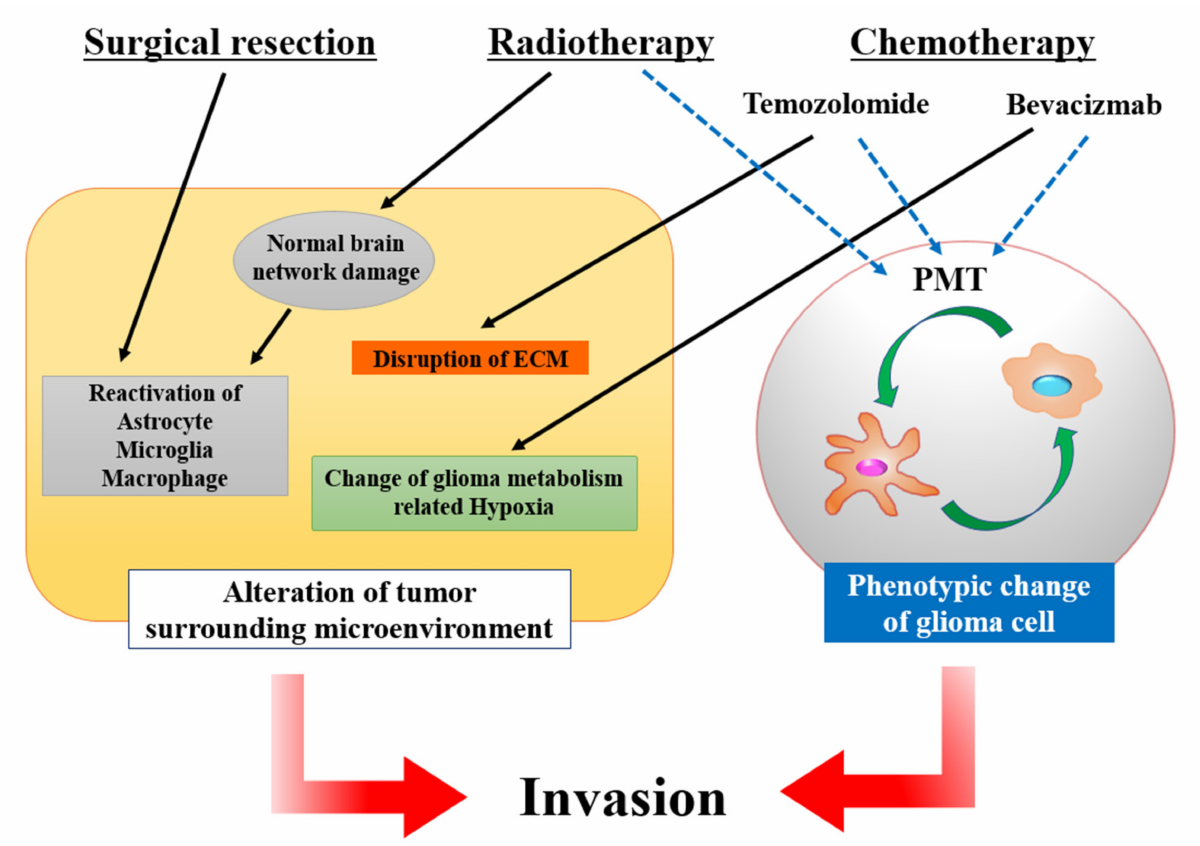
Figure 6. Schema of the mechanisms that underlie the alteration of the glioma microenvironment affected by therapy. Three main therapeutic strategies, namely surgical resection, radiotherapy, and chemotherapy, induce some mechanisms and contribute to glioma invasion in a complementary manner. Some of these mechanisms can divided into two categories: the alteration of the tumor surrounding microenvironment (black arrows), and phenotype change of glioma cells (blue arrows). Proneural mesenchymal transition (PMT) is a main program of phenotype change of glioma cells (green arrows). According to these mechanisms, glioma cells activate invasiveness (red arrows). Abbreviation: ECM, extracellular